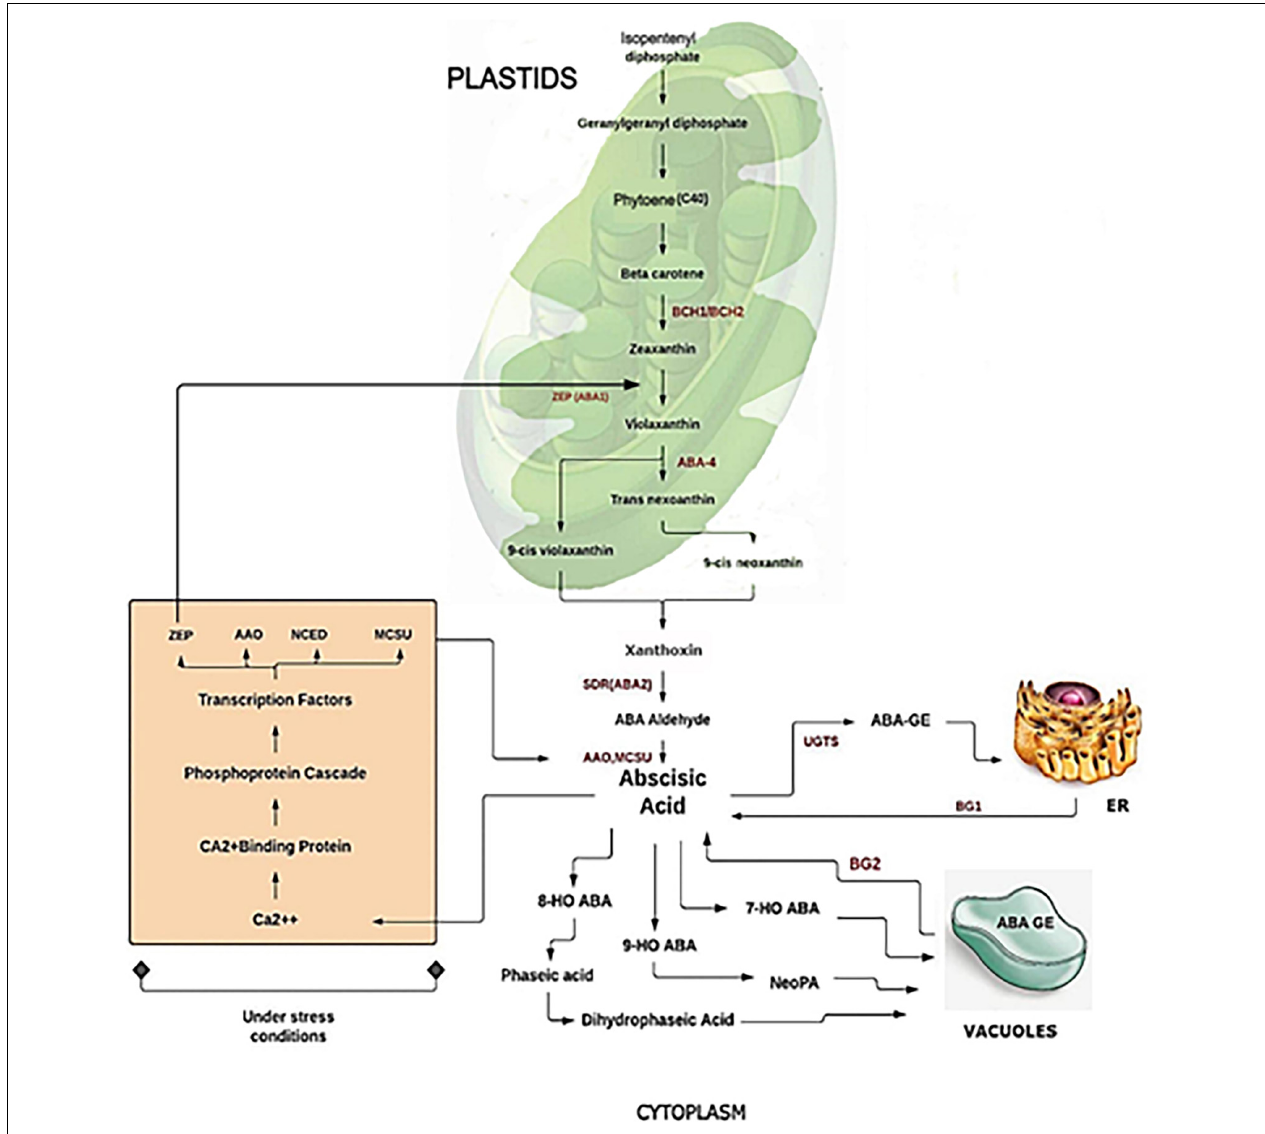
FIGURE 1 | Biosynthesis and catabolism of abscisic acid